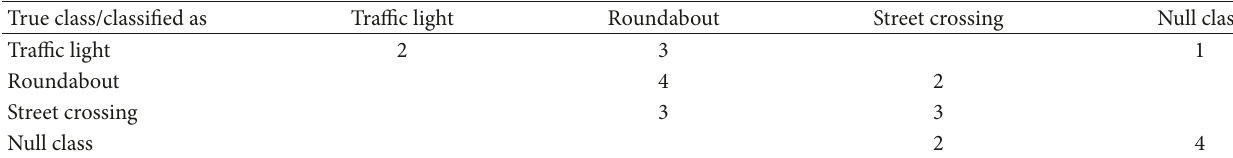
Table 7: Confusion matrix using the linear SVM classifier.